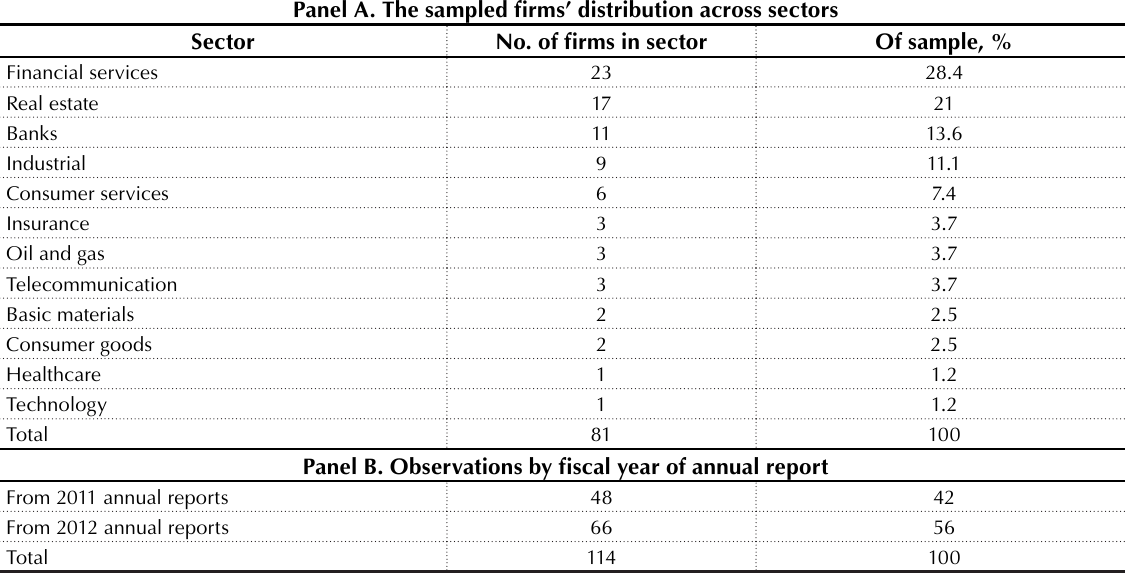
Panel A. The sampled firms’ distribution across sectors